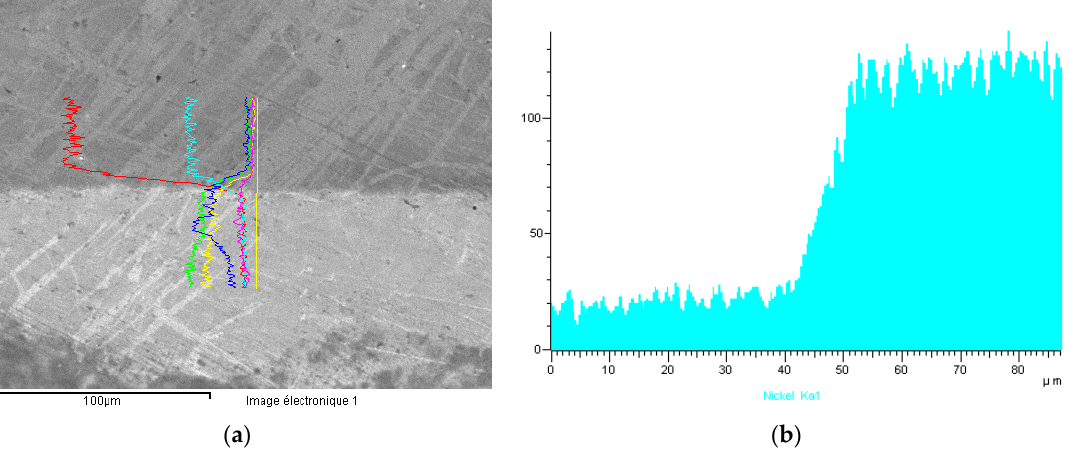
Figure 24. Sample #6. ( a ) EDX profiles of the gold-904 L steel solder for iron, nickel, silver, gold, copper and zinc; ( b ) EDX Ni profile.